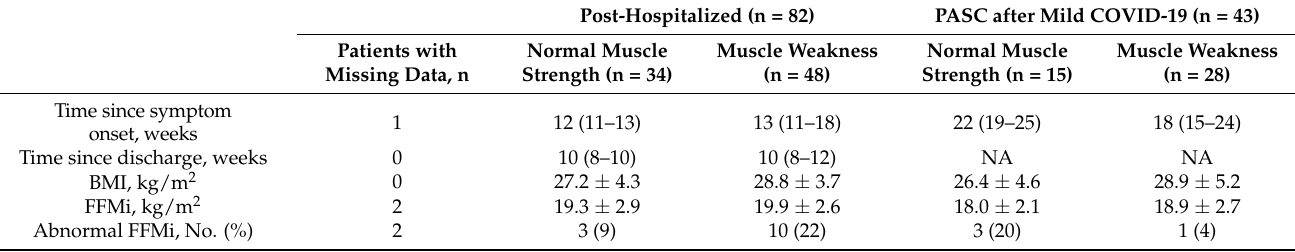
Table 3. Timing of visit 1 relative to acute COVID-19 and outcomes assessed at visit 1 of post- hospitalized and PASC after mild COVID-19 patients stratified by muscle